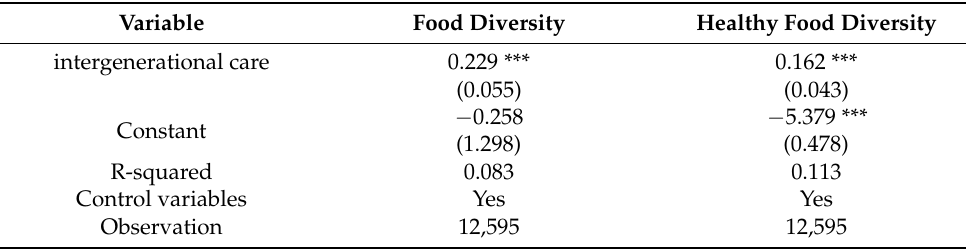
Table 6. Robustness check of the baseline estimated result. Variable Food